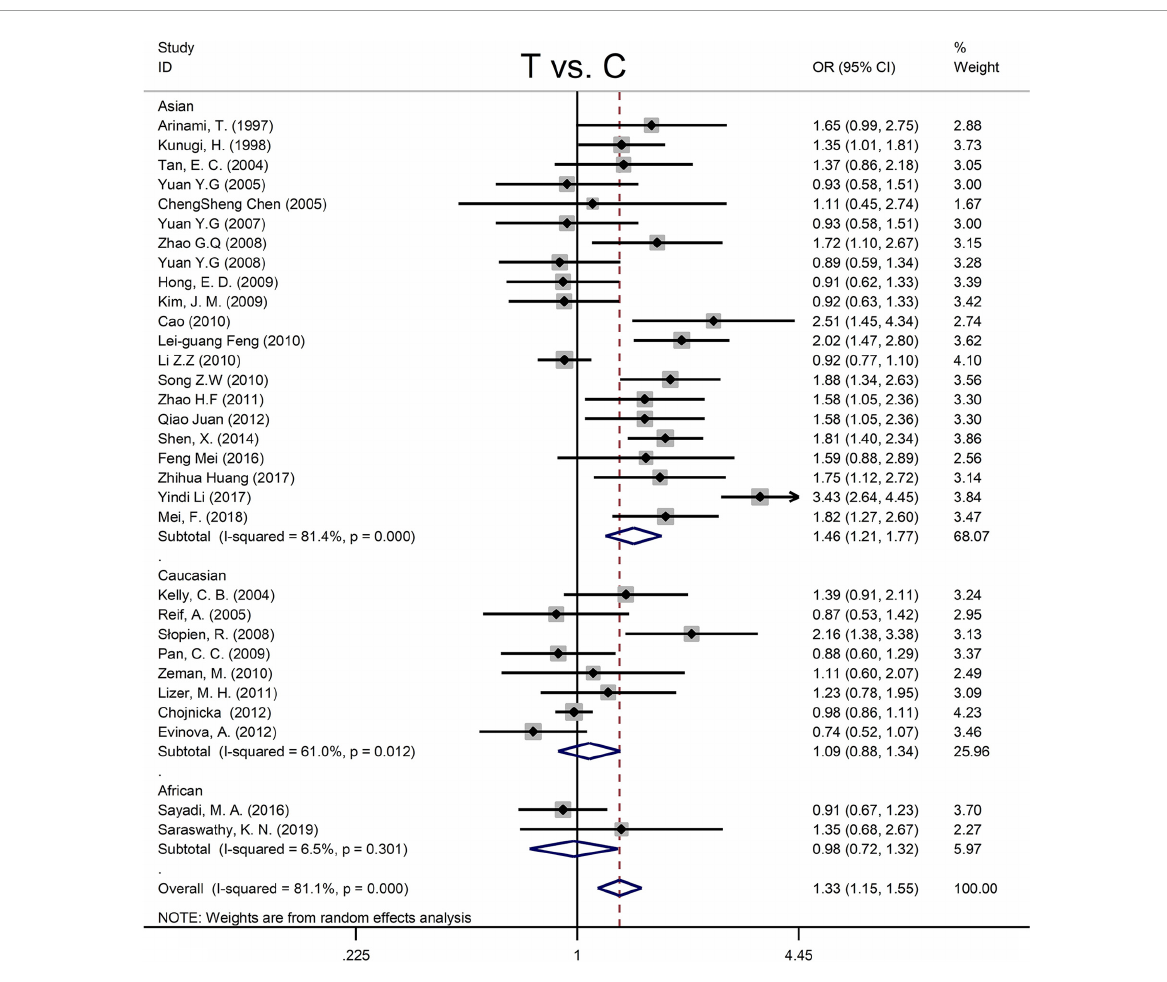
A1298C polymorphism and BPD after removing this study ( Supplementary Figure 10